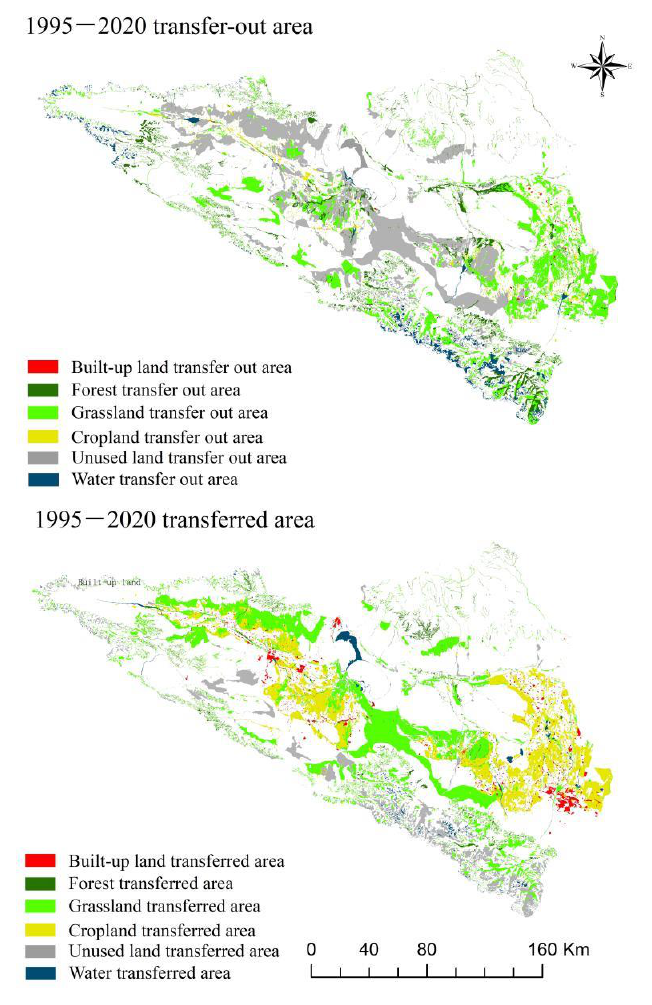
Figure 5. Spatial distribution of land-use transfer-out and transfer-in area of the Ebinur Lake Basin from